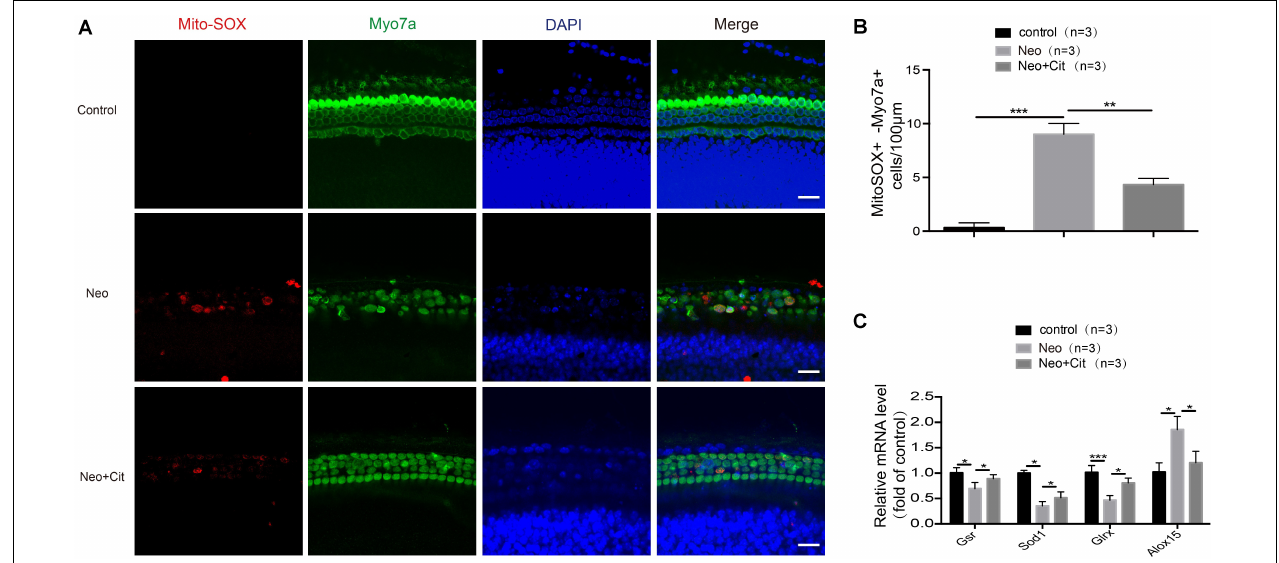
FIGURE 5 | Citicoline attenuates oxidative stress in cochlear HCs after neomycin exposure. (A) Immunofluorescence staining with Mito-SOX Red and anti-Myo7A antibodies in the middle turn of the cochlea after different treatments. (B) Quantification of the numbers of Mito-SOX Red and Myo7A double-positive cells in (A) . (C) The mRNA levels of genes related to redox reactions were analyzed by qRT-PCR after neomycin and citicoline treatment and normalized to GAPDH and presented as the fold change compared to control levels. Data are shown as mean ± SD. * p < 0.05, ** p < 0.01, *** p < 0.001. Scale bars = 20 µ